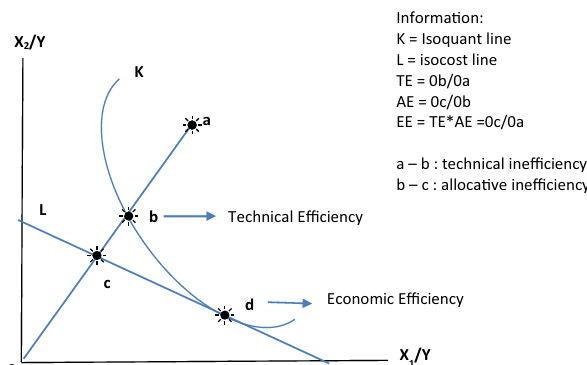
Figure 1: Isoquants, isocosts, technical e ffi ciency ( TE ) , allocative e ffi ciency ( AE ) , and economic e ffi ciency ( EE ) based on the input approach [ 33,35,36 ]